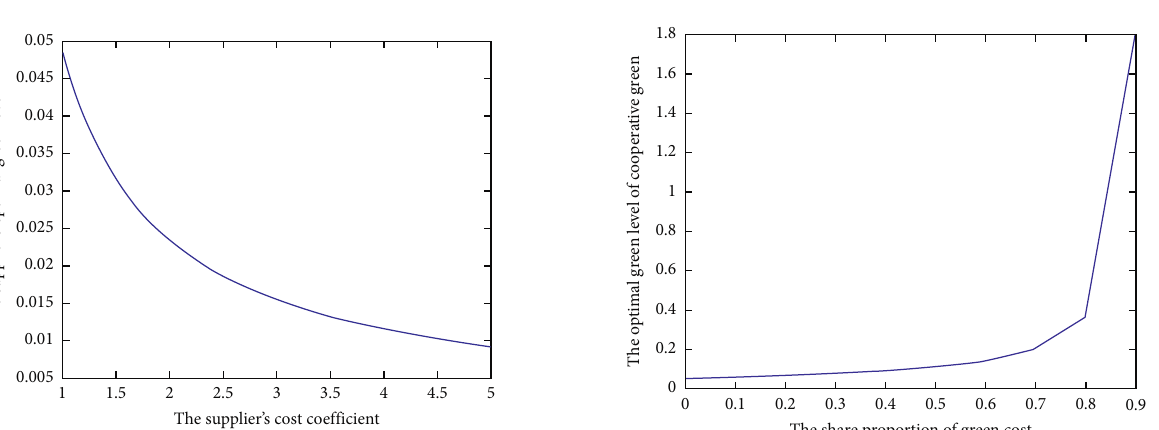
Figure 6: The relationship between the optimal green input level and the share of the manufacturer’s green cost in the case of a cooperative.